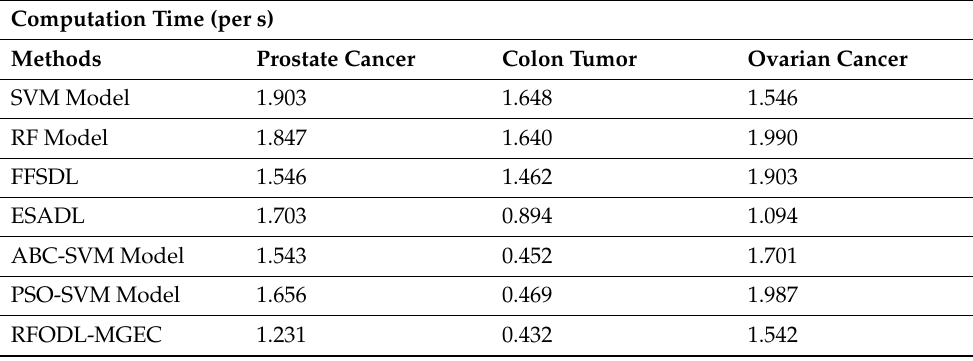
Table 8. Comparative CT analysis of RFODL-MGEC technique with recent